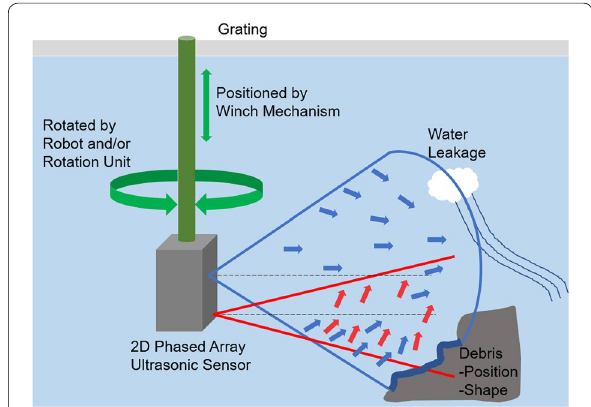
Fig. 2 Conceptual image of the flow velocity field measurement and debris measurement